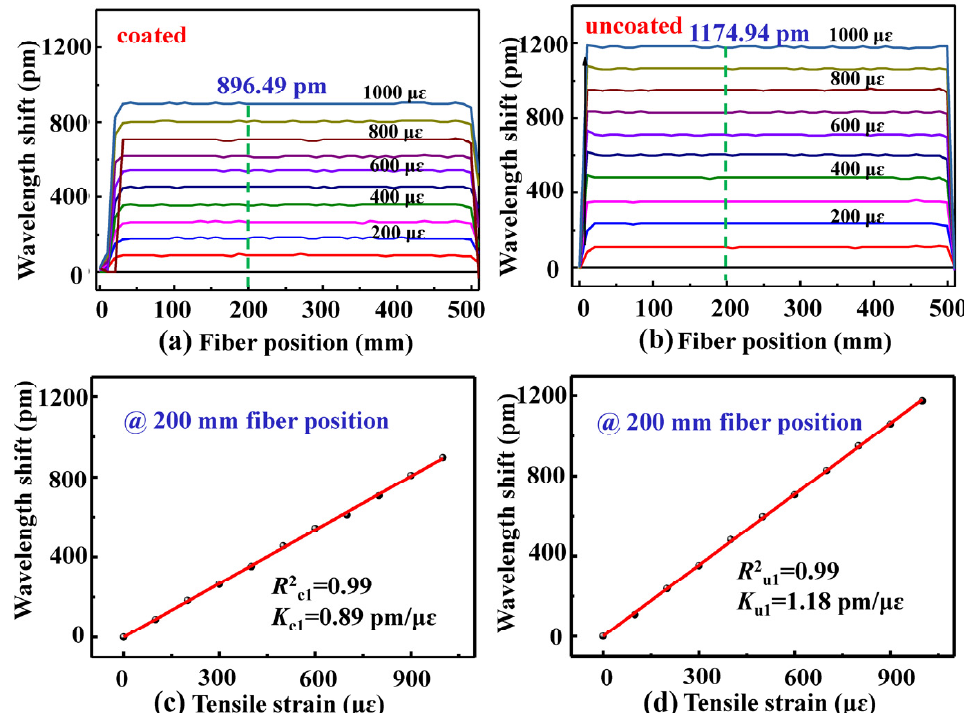
Figure 3. Wavelength shift evolution of the backscattering spectrum at the position from 0 to 500 mm along the axes of the ( a ) coated and ( b ) uncoated SMF samples while the tensile strain applied was increased from 0 to 1000 με with a step of 100 με . Wavelength shift in the backscattering spectrum at the position, e.g., 200 mm, in the ( c ) coated and ( d ) uncoated SMF samples as a function of the tensile strain applied.